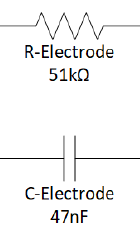
Figure 6. Electrode model according to IEC 60601–2–47 standard.